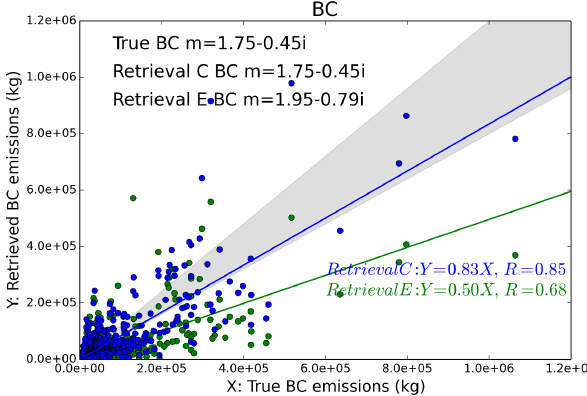
Figure 10. Test of BC particle refractive index influence on the re- trieval of BC emissions. The scatter plots are a grid-to-grid com- parison of retrieved 16-day averaged emissions (blue: Retrieval C; green: Retrieval E) with the “true” BC emissions. The shaded grey area represents ± 20% differences around the true